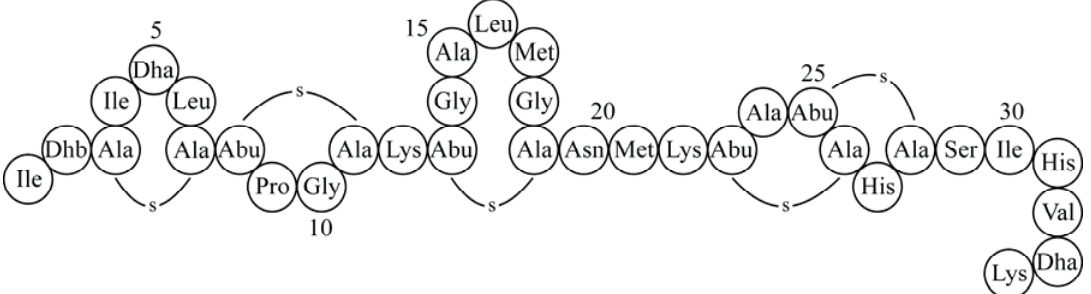
Figure 1. Nisin A. Dha, dehydroalanine; Dhb, dehydrobutyrine; Ala-S-Ala, mesolanthionine; Abu-S-Ala, β